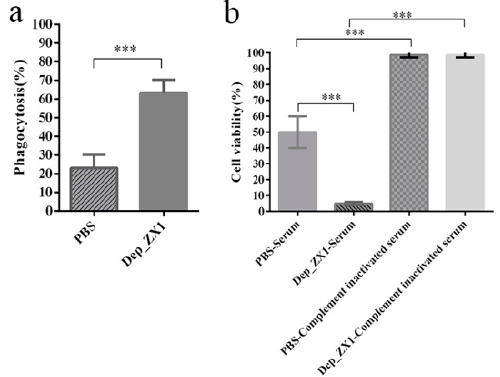
Figure 8. Depolymerase Dep_ZX1 improves the phagocytosis and serum sensitivity of K. pneu ‐ moniae 111 ‐ 2. ( a ) Phagocytosis of phagocytes to K. pneumoniae 111 ‐ 2 treated with PBS or Dep_ZX1. ( b ). The cell survival rate of K. pneumoniae 111 ‐ 2 treated with PBS or Dep_ZX1 incubated with se ‐ rum or complement ‐ inactivated serum. p < 0.05 (*), 0.01 < p < 0.05 (**), 0.001 < p < 0.01 (***) and p < 0.001(****).